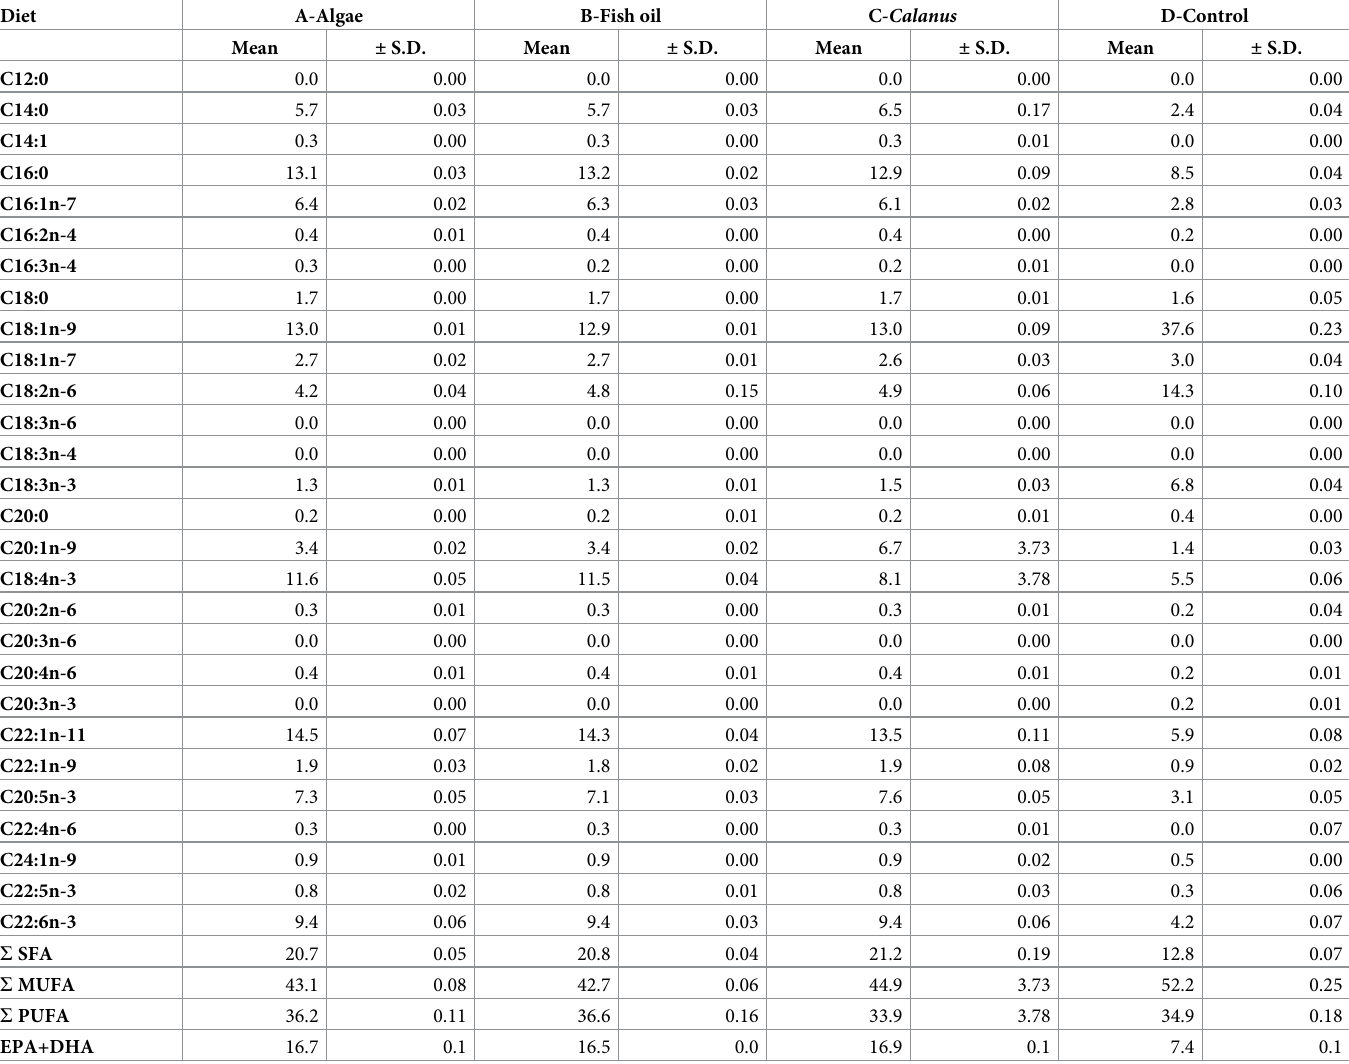
Table 5. Fatty acid content of diets as weight % of total lipid, n = 5, SFA = Saturated fatty acids, MUFA = Monunsaturated fatty acids, PUFA = Polyunsaturated fatty